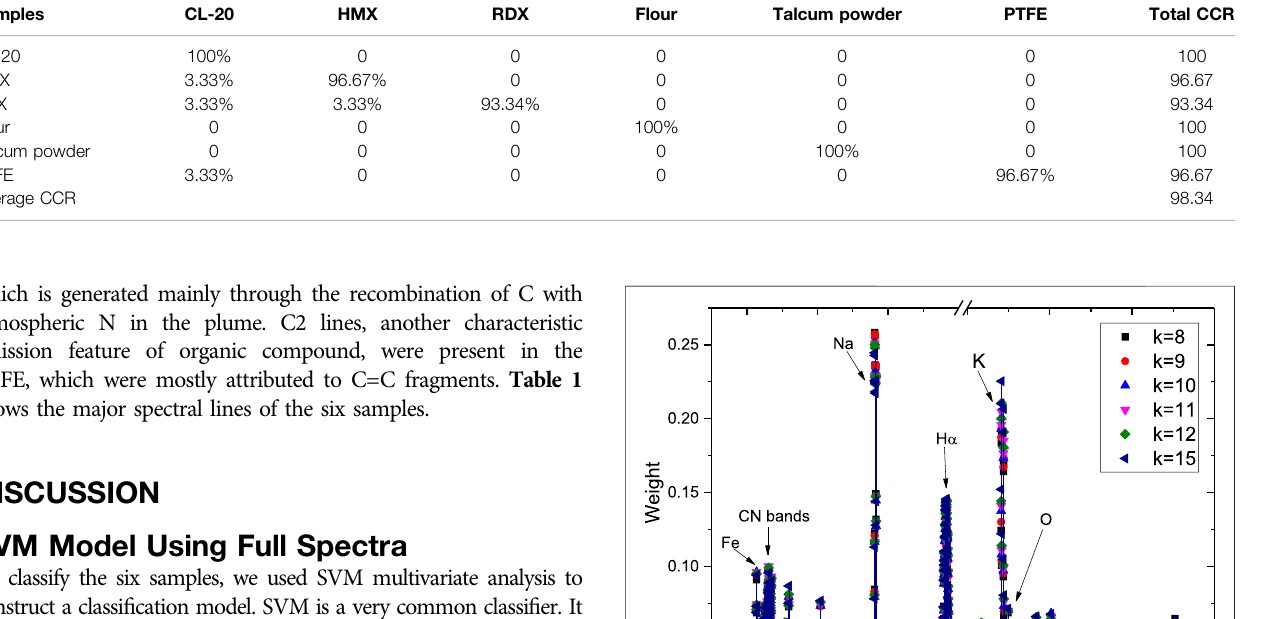
TABLE 5 | CCR of SVM3 model using 100 lines with high weights (weight threshold > 0.05). Samples